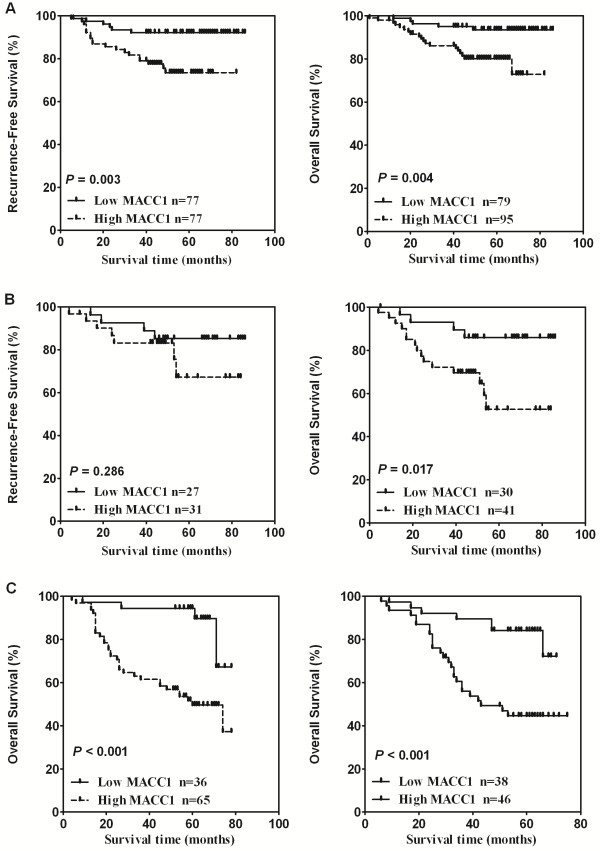
Kaplan-Meier estimates of relapse-free survival and overall survival according to MACC1 expression level in subgroups of ER- and ER+ patients in two independent datasets. A. Relapse-free survival and overall survival of ER+ breast cancer patients in cohort 1. B. Relapse-free survival and overall survival of ER- breast cancer patients in cohort 1. C. Overall survival of ER+ and ER- breast patients in cohort 2.